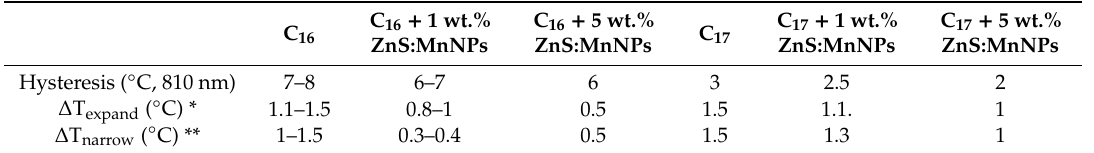
Table 2. Results for tested transducers based on tapered optical fiber (TOF) and higher alkanes with di ff erent doped ratio of ZnS Mn nanoparticles (NPs). C 17 + 1 wt.% C 17 + 5 wt.% C 16 + 1 wt.% C 16 + 5 wt.% C 17 C 16 ZnS:MnNPs ZnS:MnNPs ZnS:MnNPs ZnS:MnNPs Hysteresis ( ◦ C, 810 nm) 3